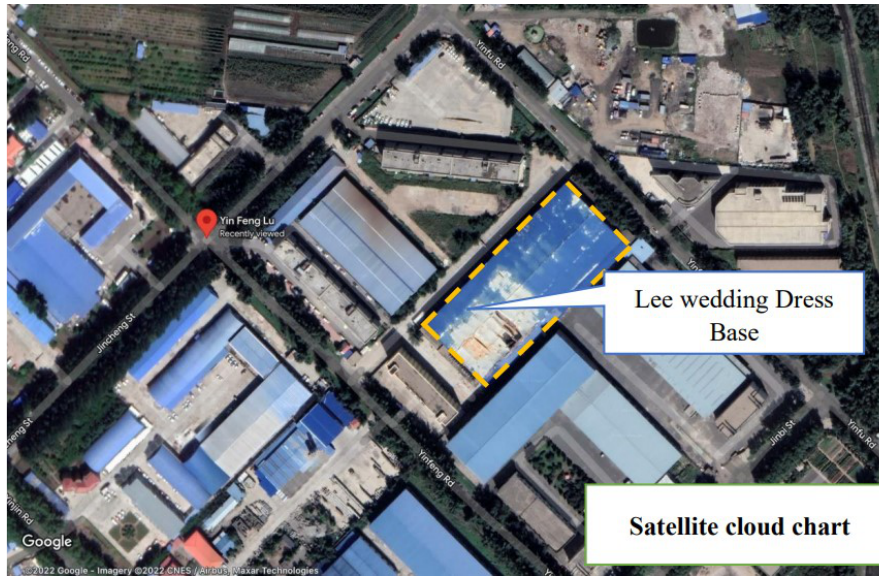
Figure 2. Electrical fires: complete picture of the incident (from Google map).